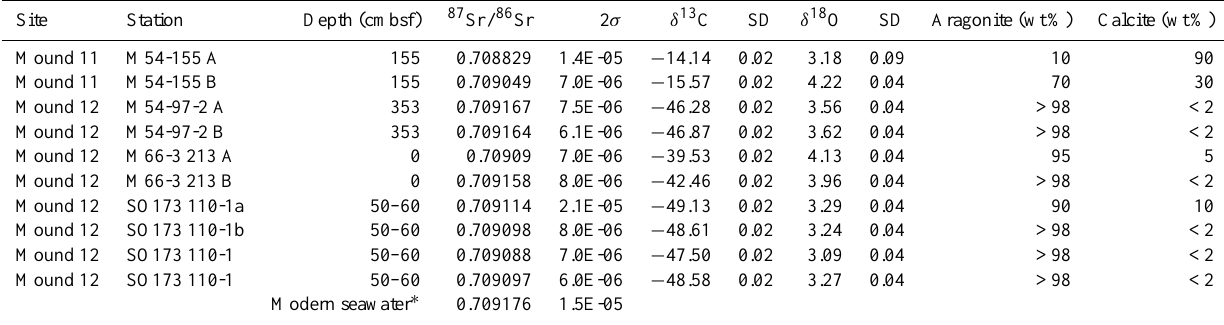
Table 6. List of 87 Sr/ 86 Sr ratios, δ 13 C, and δ 18 O of carbonate-dominated fragments from Mound 11 and 12 carbonates obtained during cruises M54, M66, and SO173. Second standard error (2 σ) and standard deviations (SD) are